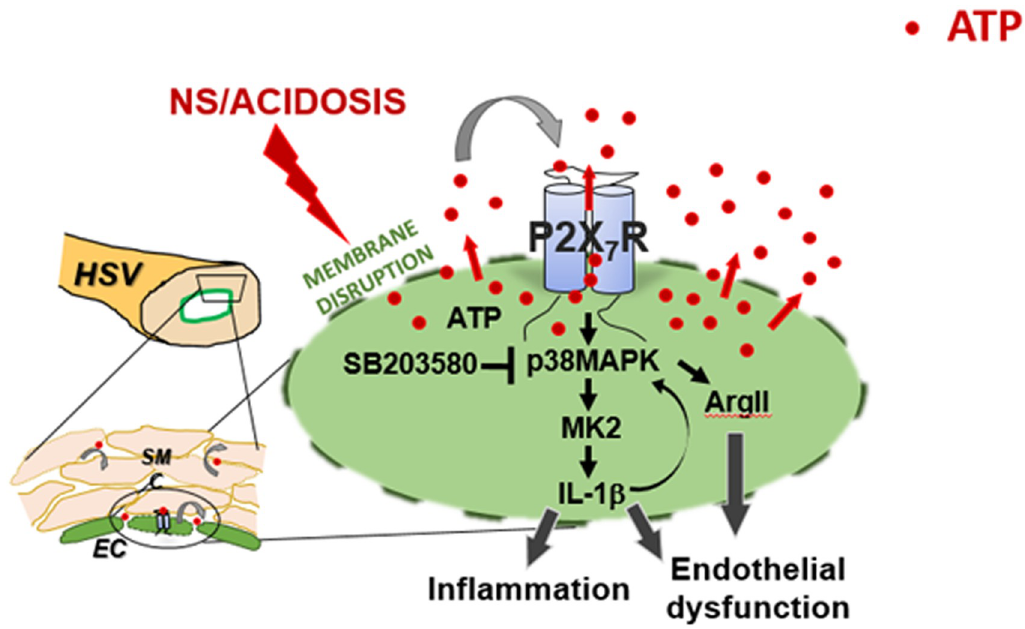
Fig 7. Model of molecular mechanisms of vascular injury to endothelium by ATP. Injury to vascular tissues (including storage of vein graft in Normal Saline) leads to membrane disruption and ATP release. Extracellular ATP activates the P2X 7 R/ p38MAPK pathway, leading to IL-1 β production and inflammation. Activation of P2X 7 R leads to increased extracellular ATP via release from P2X 7 R channels/pores. Prolonged exposure to IL-1 β leads to increased arginase II expression and activation of P38MAPK, which contributes to endothelial dysfunction and amplification of the response to injury.